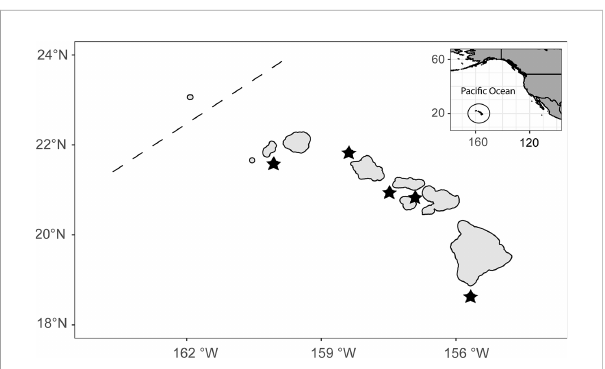
FIGURE 1 Map of the study region, the main Hawaiian Islands fi shing zone (MHI). The inset indicates the position of the MHI in the Paci fi c Ocean. Poleward of the dashed line is the southernmost end of the Papaha ̄ naumokua ̄ kea Marine National Monument (PMNM) which separates the MHI from formerly fi shed bottom fi shing areas that no longer are fi shed in the Mau and Ho ’ omalu zones of the PMNM. Stars indicate the general fi shing locations where samples were